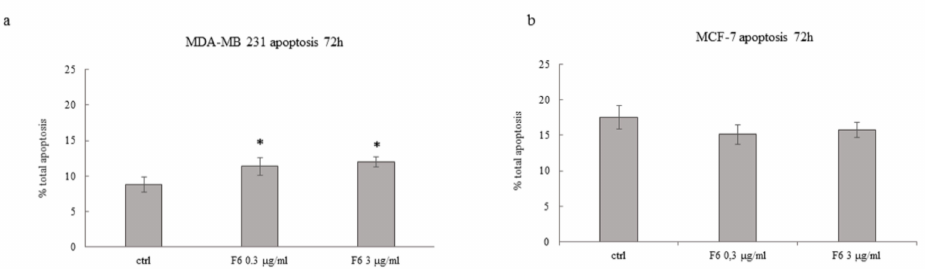
Figure 1. E ff ect of Zebrafish embryo F6 fraction on apoptosis of MDA-MB-231 ( a ) and MCF-7 ( b ) cells after 72 h of treatment with F6 at 0.3 and 3 µ g / mL. Histograms showing the percentage of apoptotic cells; each column represents the mean value ± SD of four independent experiments. * p < 0.05 versus ctrl by ANOVA followed by Bonferroni